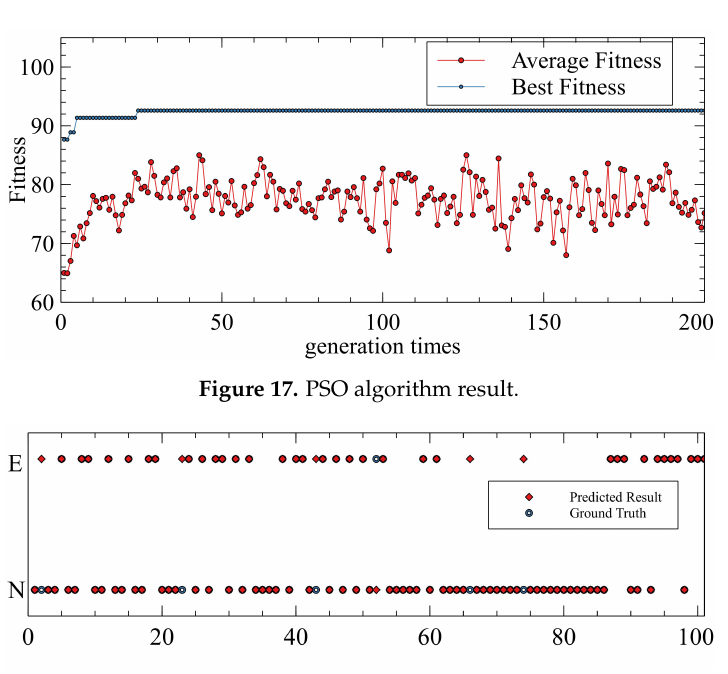
Figure 18. Classification